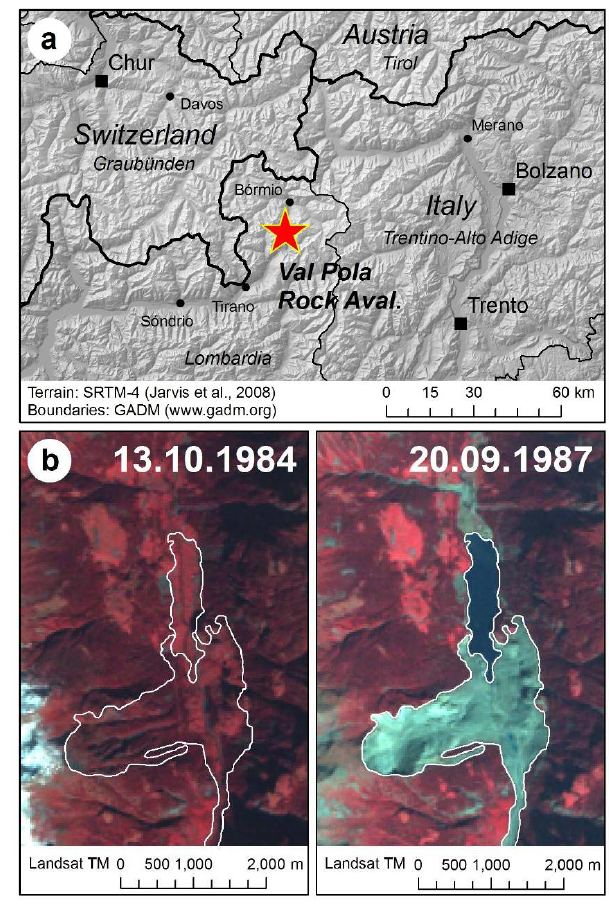
Fig. 3: Val Pola Rock Avalanche: (a) location; (b) comparison of Landsat imagery before and after the event.